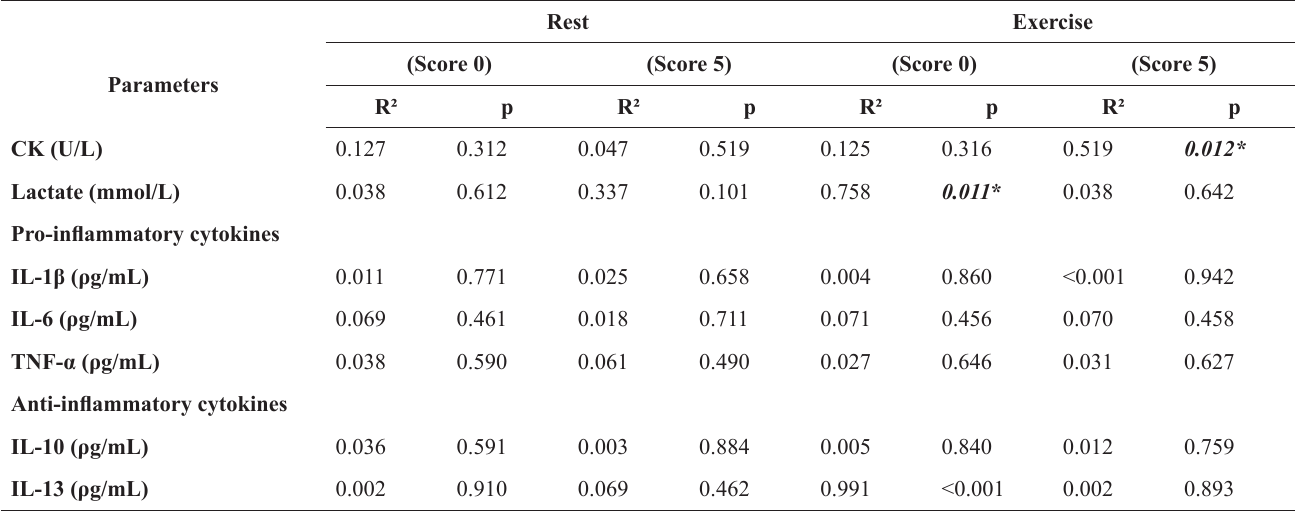
Table 3 - Linear regression analysis for CK, blood lactate, pro- and anti-inflammatory cytokines and total intake at score 0 and score 5. * Signifi - cance was found for blood lactate at score 0 and CK at score 5 with p <0.05 significance level. Subtitle: CK (creatinine kinase); Score 5 (“I